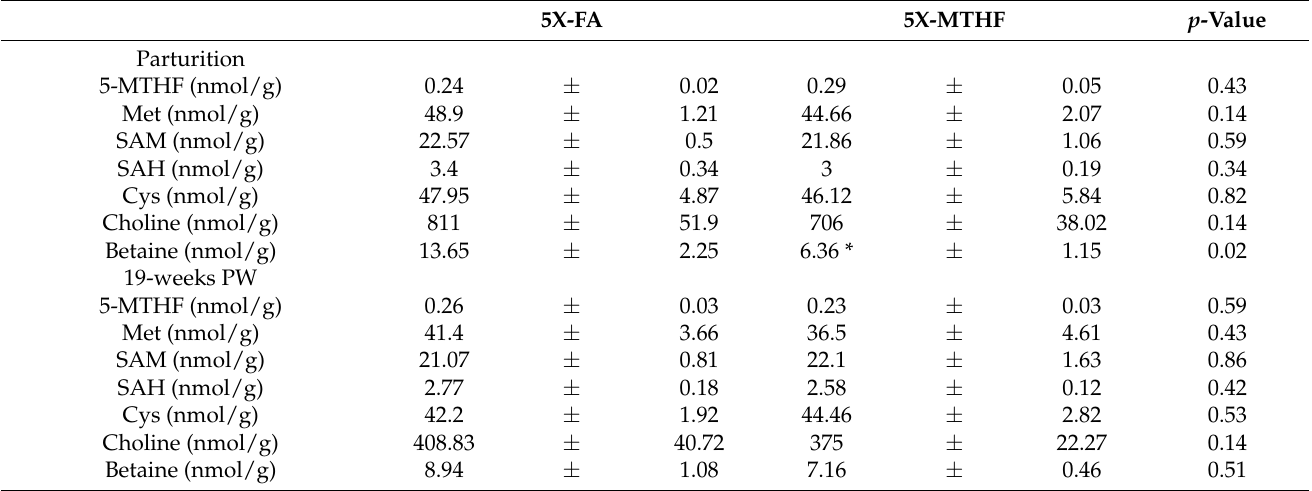
Table 5. Brain 5-MTHF and 1-carbon metabolites upon parturition and at 19-weeks post-weaning (PW) of dams fed 5X-FA or 5X-MTHF pregnancy diets.